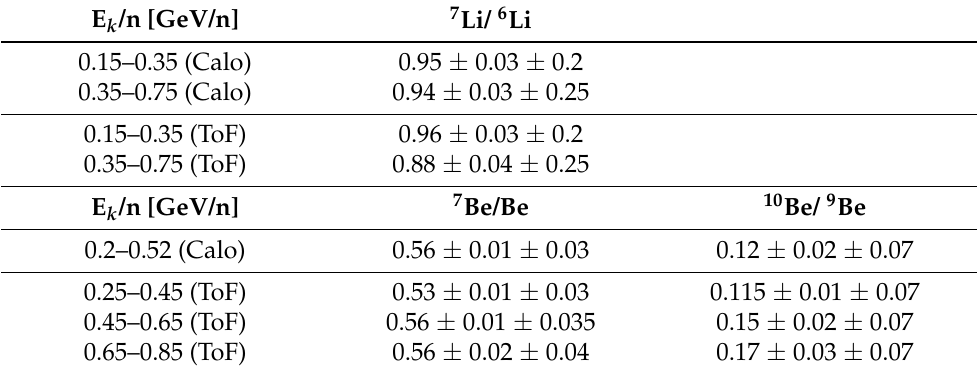
Table 1. Results of the data-driven analysis applied to PAMELA Li and Be events.